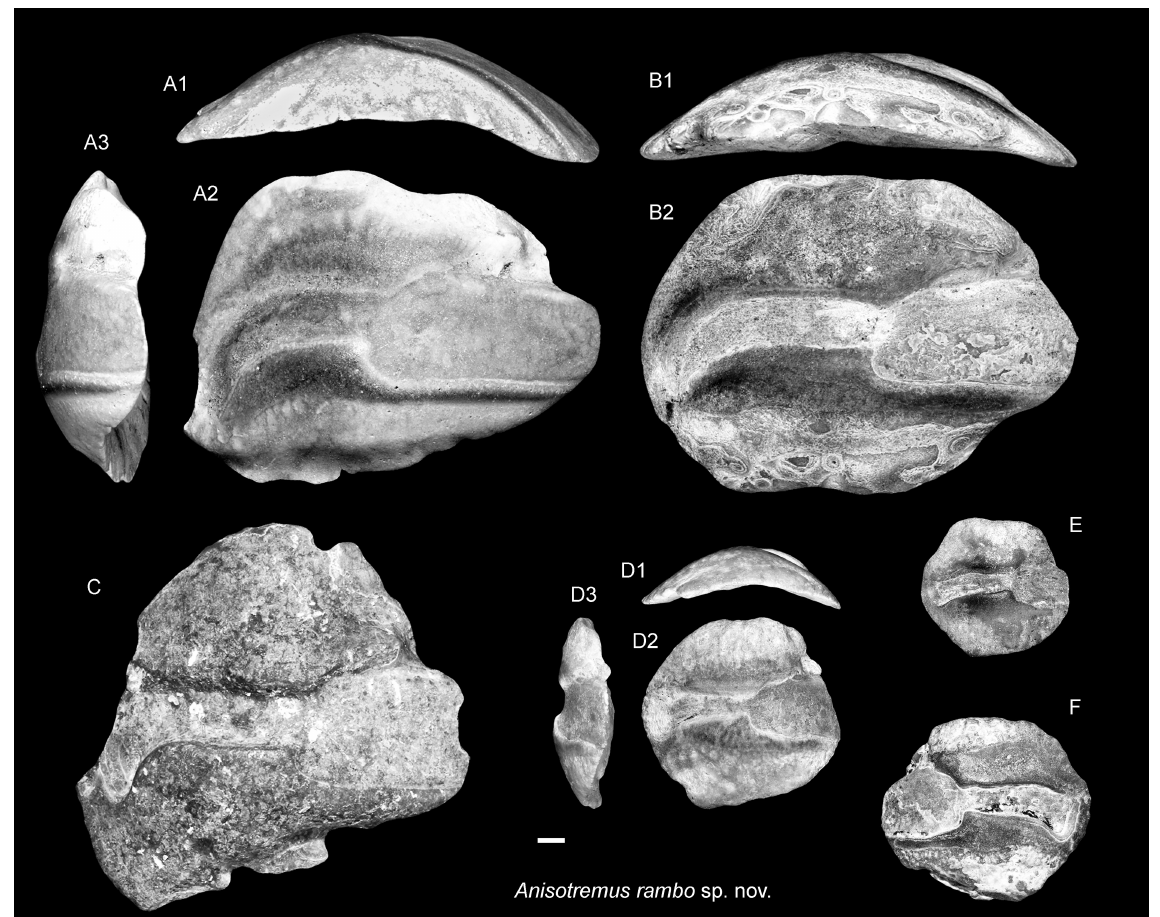
Fig. 30. Otoliths of Anisotremus rambo sp. nov. from the US middle and upper Eocene. A–B . “Stone